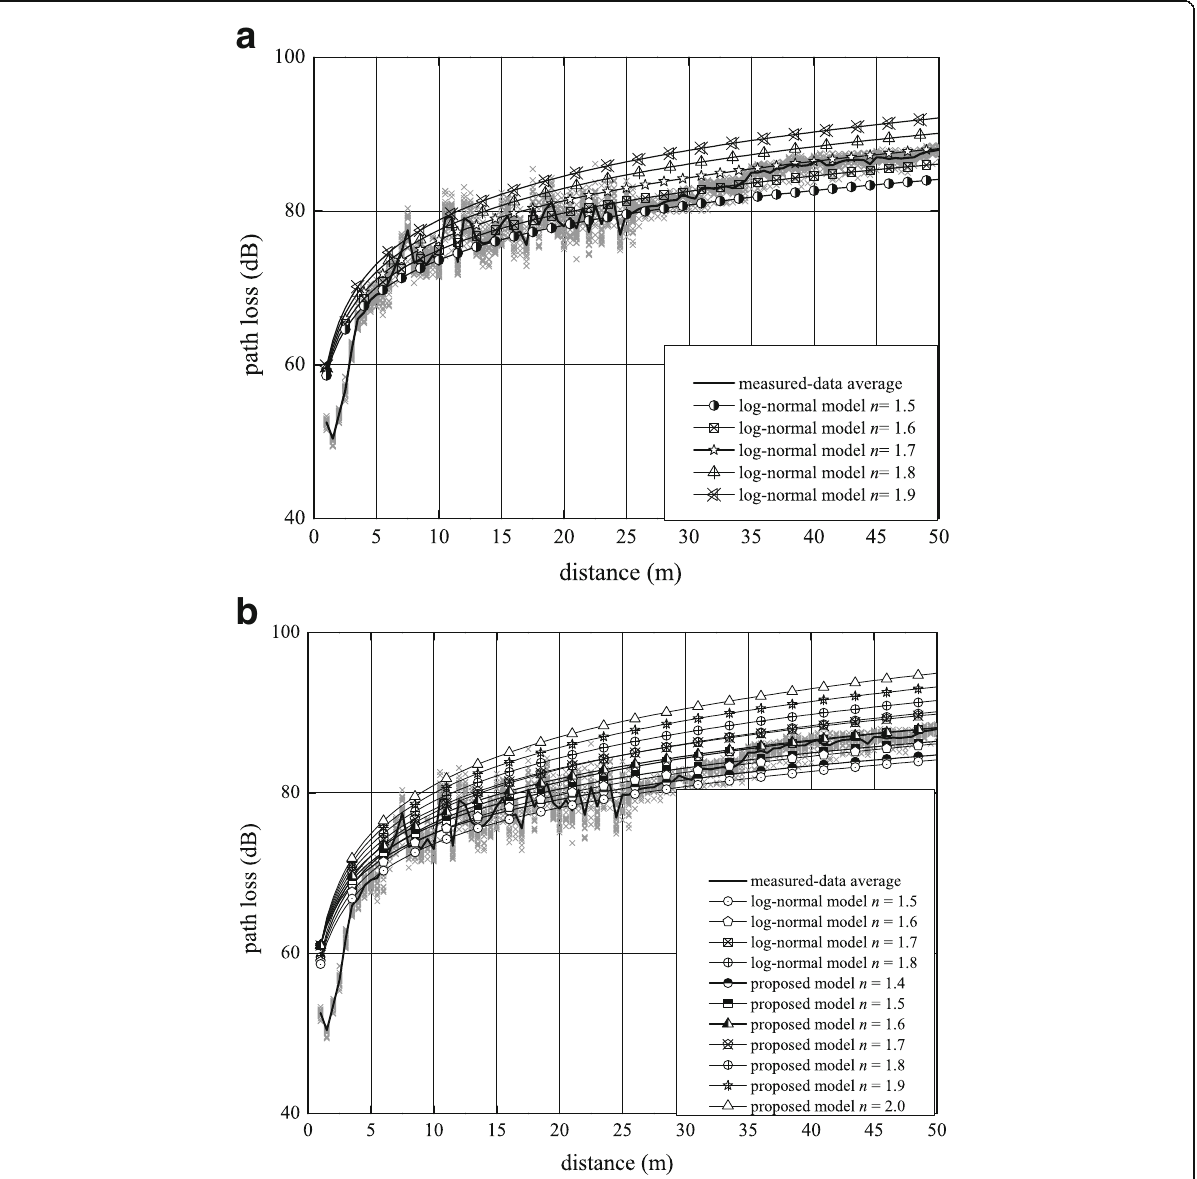
Fig. 4 Path loss of a log-normal model and b developed propagation model, compared with measurement data of the first case with antennas on the